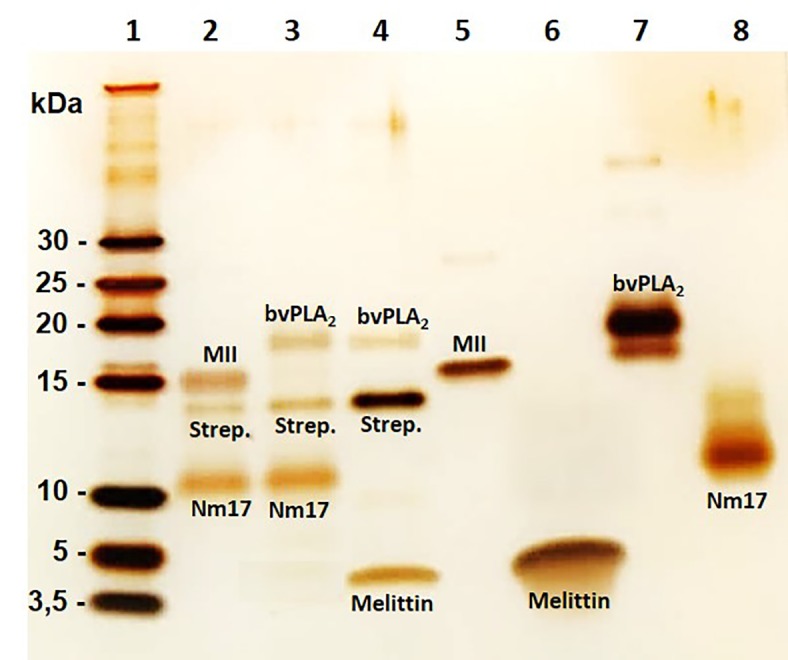
Electrophoresis profiles of toxins and toxin complexes isolated in a pull-down experiment. Different combinations of cytotoxins and PLA2s (5 µg of each and one of them biotinylated) were co-incubated for 1 h at 37°C. This was followed by a pull-down experiment using Dynabeads M280 Streptavidin. Toxins were eluted with lithium dodecyl sulphate (LDS) and dithiothreitol (DTT) and heated at 70°C for 10 min. Eluted toxins were evaluated using a Tris-Tricine SDS-PAGE 16% and silver staining. Lane 1: Ladder; Lane 2: bio-MII + Nm17; Lane 3: bio-Nm17 + bvPLA2; Lane 4: bio-melittin + bvPLA2; Lane 5: MII; Lane 6: melittin (control); Lane 7: bvPLA2 (control); Lane 8: Nm17 (control). No protein band was seen when combinations with non-biotinylated toxins were used (data not shown). Strep. means streptavidin.